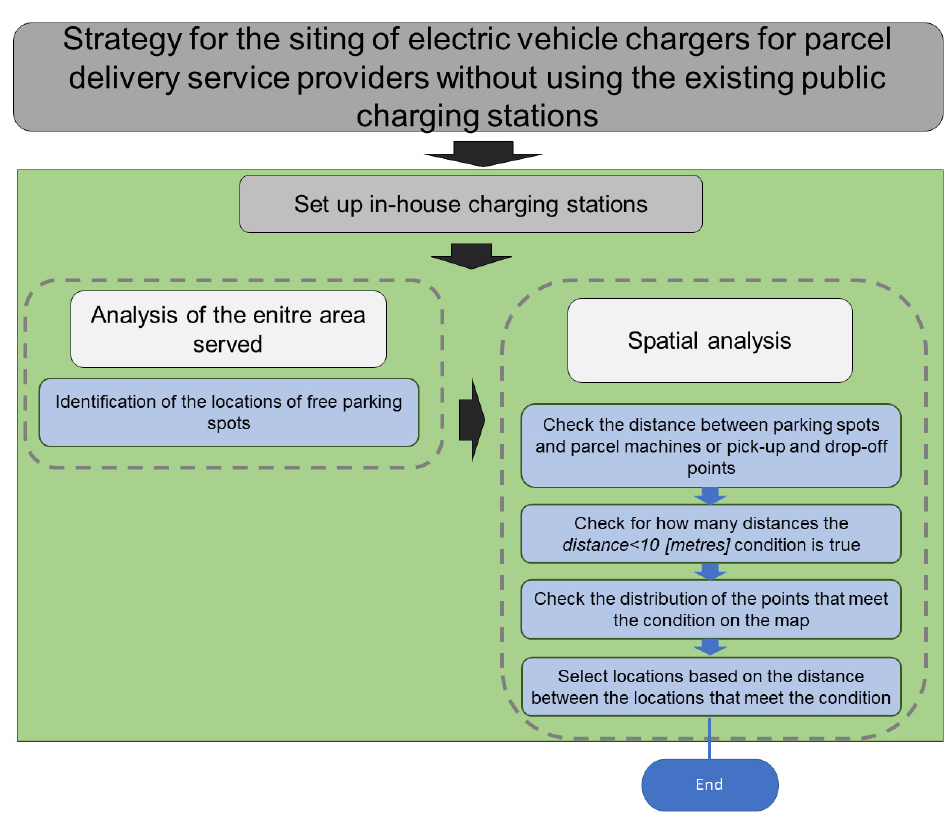
Figure 2. Diagram of the second strategy for establishing potential electric vehicle charging sites for courier companies.